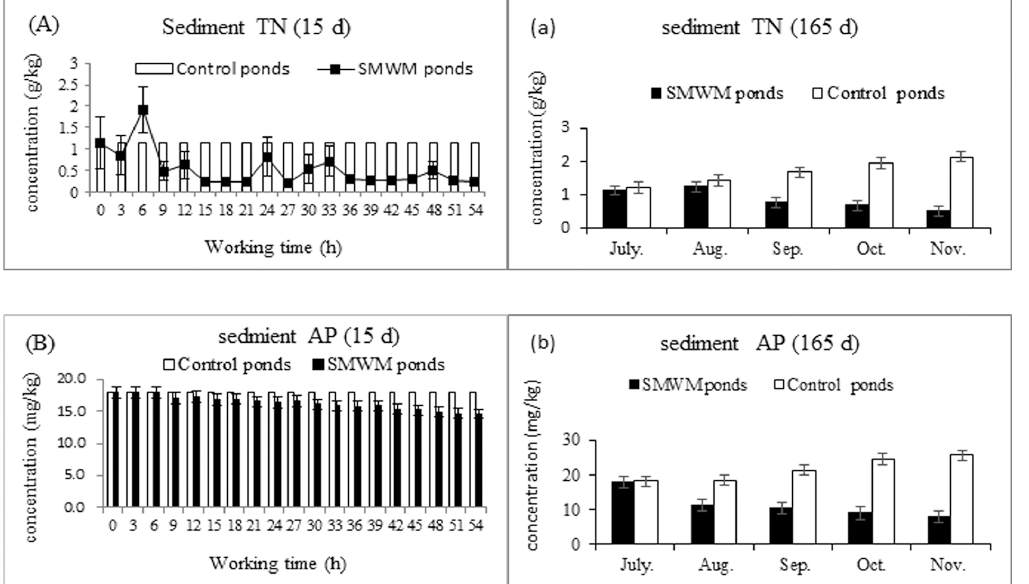
Fig 9. Influence of SMWM on bream culture pond sediment. (A) and (B) were the concentrations of TN and AP in used SMWM ponds and control ponds seiment at the beginning 15 days (From June 1 to 15, 2013 the SMWM operation 54 hours). (a) and (b) were the concentrations of TN and AP in used SMWM ponds and control ponds sediment in 165 days (From June 1, 2013 to November 15,